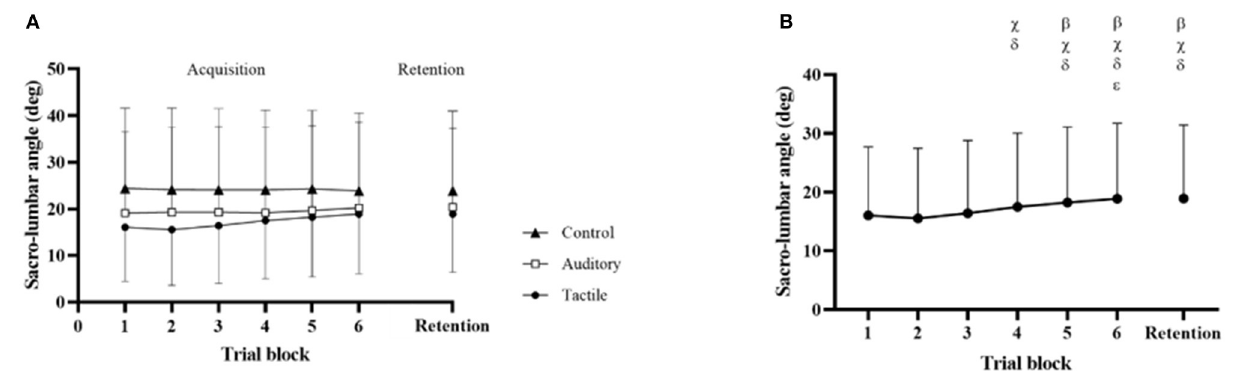
Influence of Initial Spine